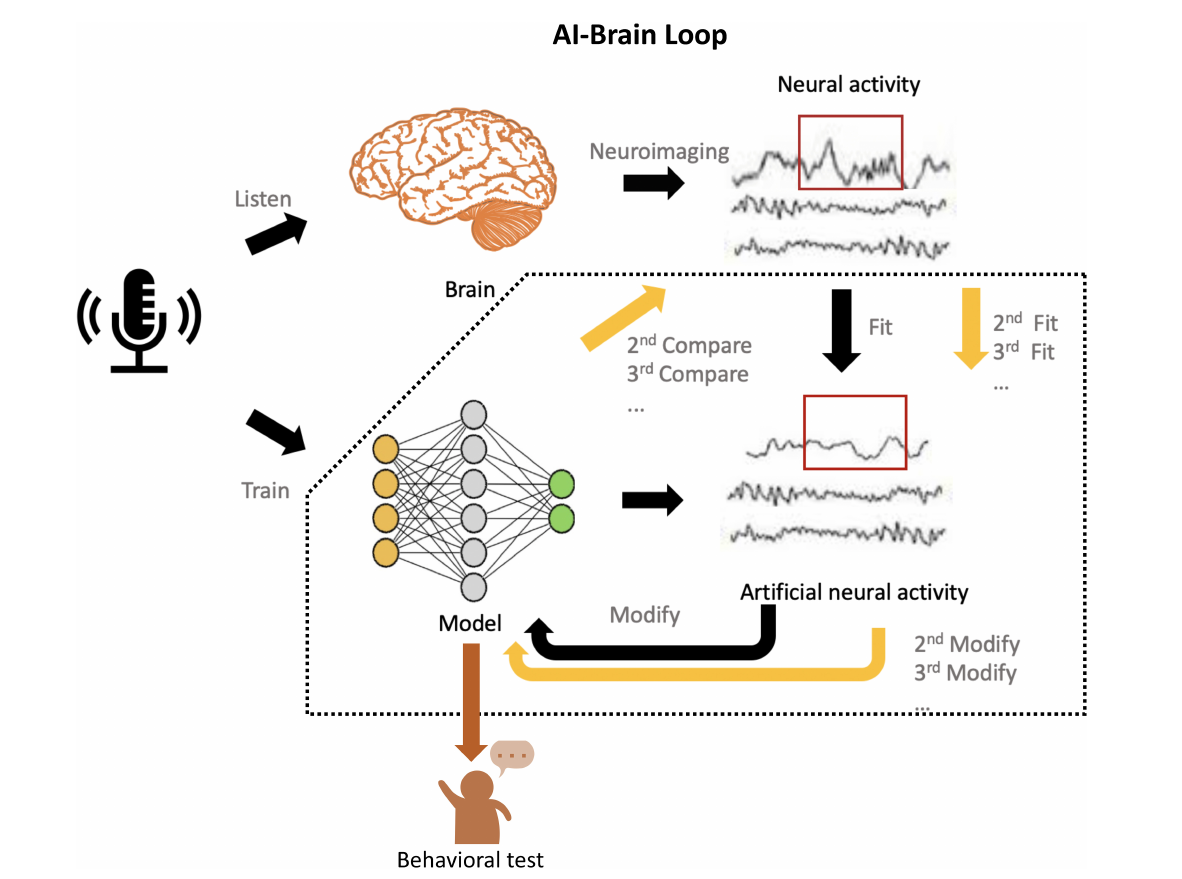
FIGURE2 Schematic of the AI-Brain loop. First, present the same task (e.g., audio recognition) to human subjects and AI models, which are subsequently trained for this task. Second, record the neural activities in the brain by neuroimaging techniques (e.g., fMRI., EEG., MEG., ECoG), and predict neural responses with these trained AI models. Third, compare the recorded neural activity and the artificial neural activity generated by models. Fourth, use the artificial neural activity to fit the neural activity by modifying the corresponding layers or parameters. Fifth, implement the behavioral evaluation of model and see whether the performance achieve the human-like level. If not, implement the continuous fit until it achieves the both human-like and brain-like